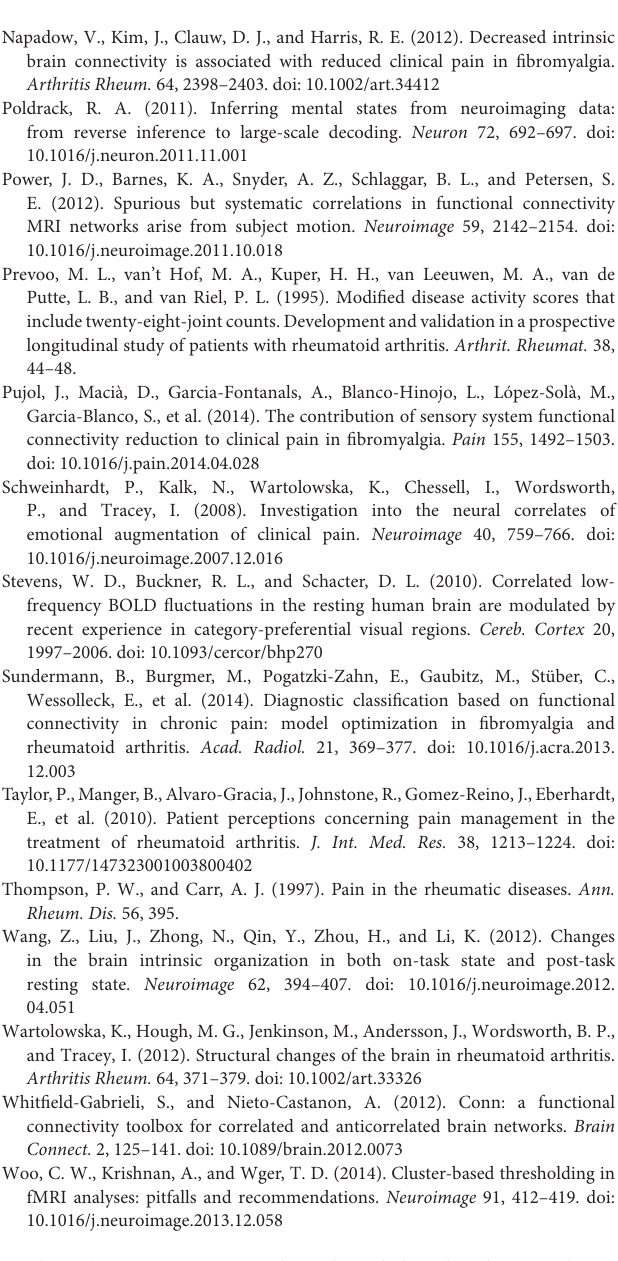
was performed by using the Harvard-Oxford Cortical/Subcortical structural atlas or the Juelich Histological Atlas as provided by FSLview. Supplemental Figure S1 | Spatial distribution of seed regions placed in pain processing brain